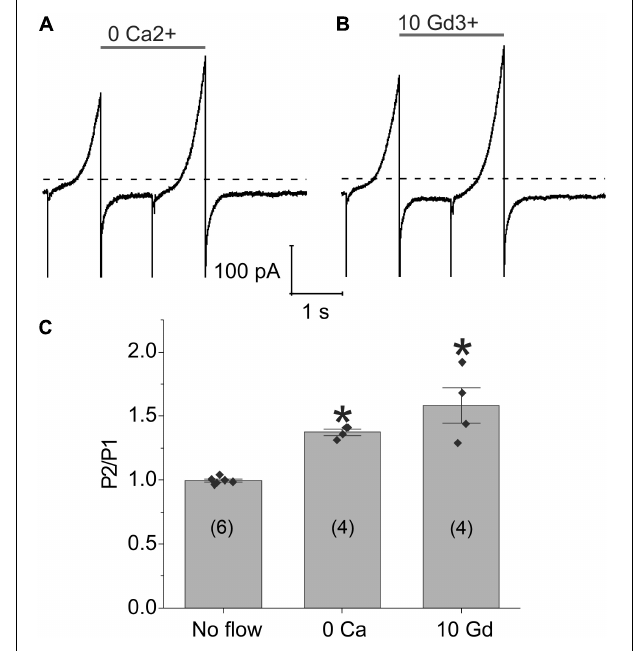
FIGURE 4 | Application of shear stress caused a significant increase in chloride currents even in the absence of external calcium. Representative experiments showing the effect of fluid flow on the whole cell current recorded using a paired ramp protocol in panel (A) the nominal absence of external calcium or (B) the presence of 10 µ M Gd 3 + . (C) Bar graph summarizing the effect of zero-added calcium and 10 µ M Gd 3 + on the amplitude of the membrane current recorded at 100 mV during the second ramp peak (P2) normalized with respect to the current recorded at 100 mV during the first ramp peak (P1) calculated as mean ± standard error of the mean (SEM). The number of cells tested is indicated within parentheses. Significant differences (*) are relative to the absence of flow. The bath solution contained NMDG-Cl solution. The pipette solution consisted of NMDG-Cl internal solution containing ∼ 300 nM [Ca 2 + ] i . Dashed line represents zero current